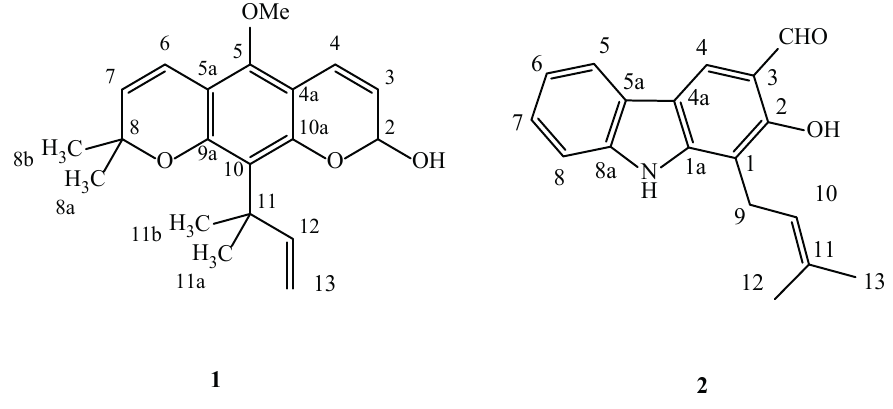
Figure 1: The structure of isolated compounds 1 and 2 from C.